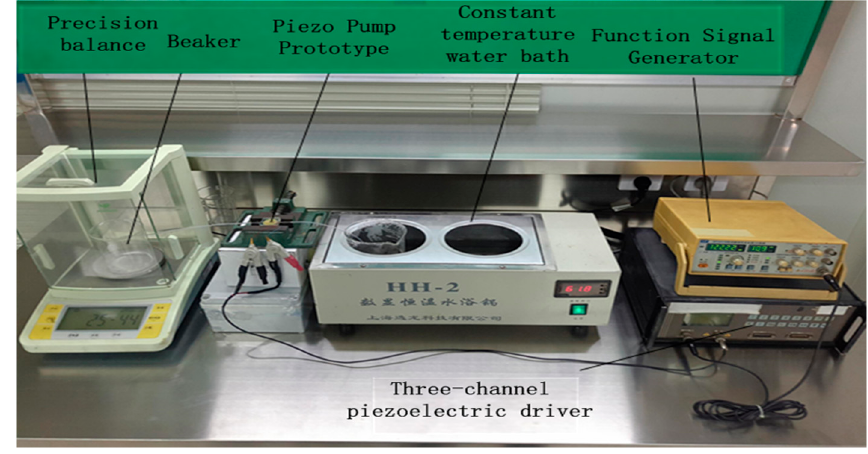
Figure 5. As-constructed device.